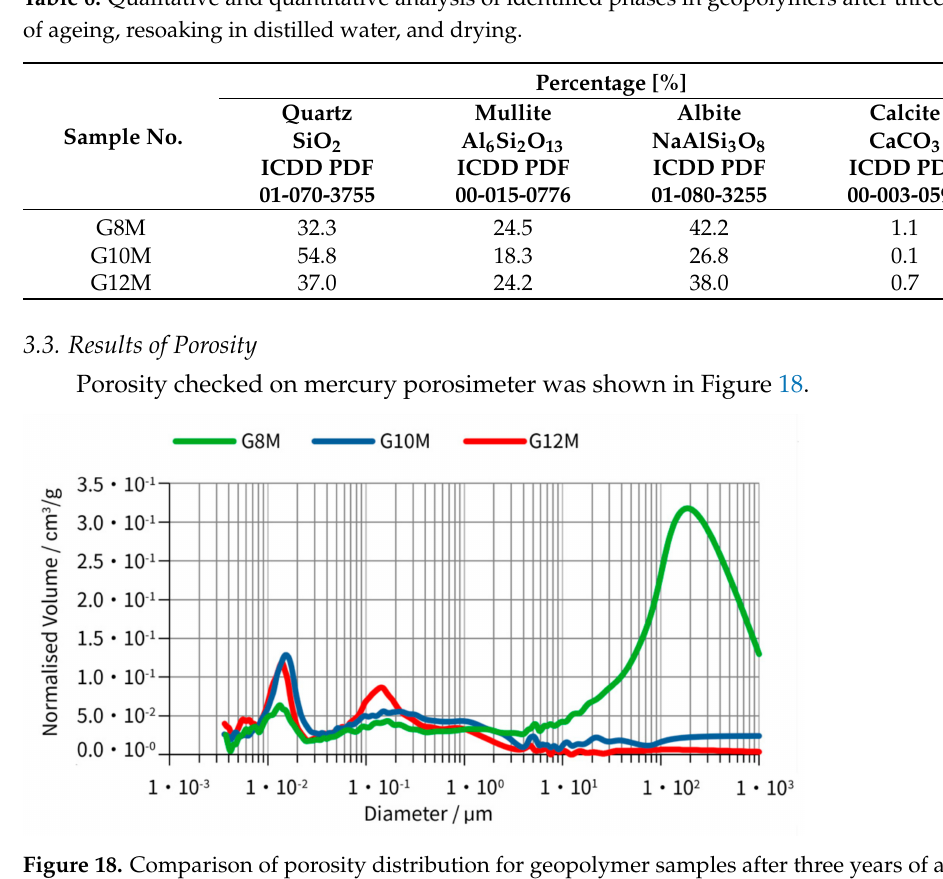
Figure 18. Comparison of porosity distribution for geopolymer samples after three years of ageing, resoaking in distilled water, and